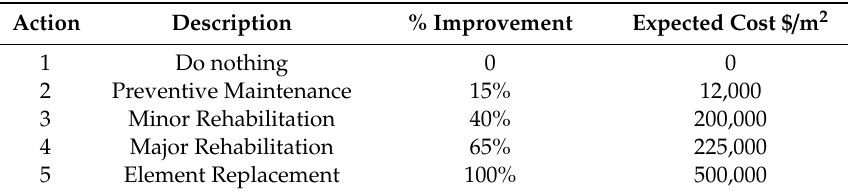
Table 4. M&R Treatments and their E ff